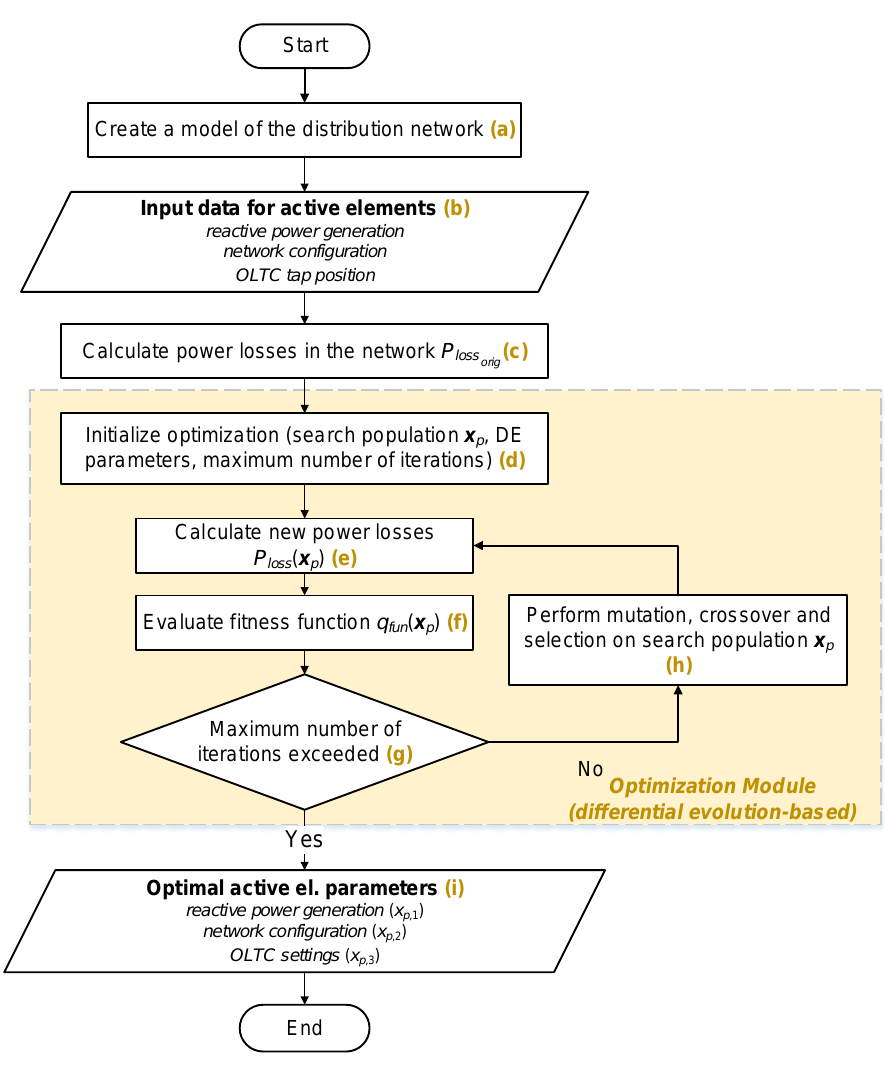
Figure 1. Flowchart of the proposed procedure for optimization of a network